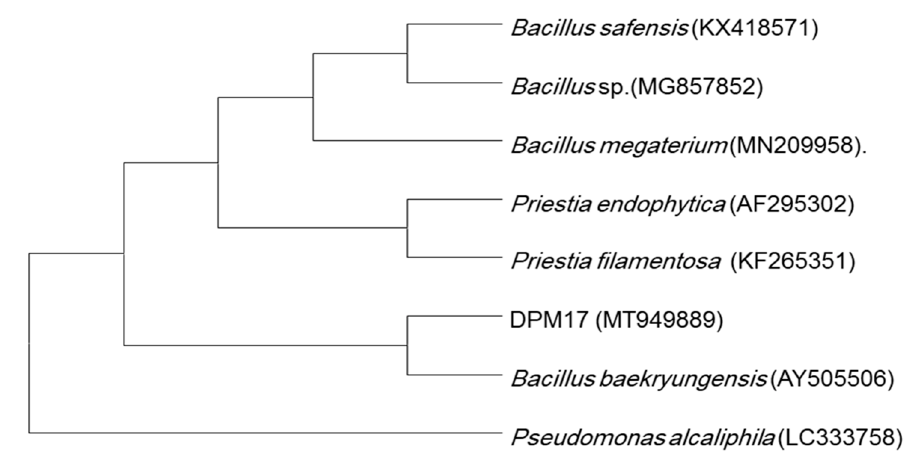
Figure 2. The evolutionary relationships of DPM17 and closely related bacterial species.